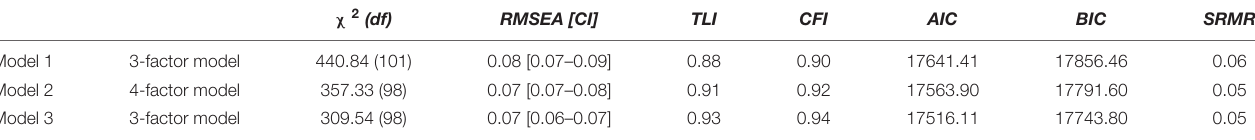
TABLE 3 | The CFA of the C-SDS ( n =